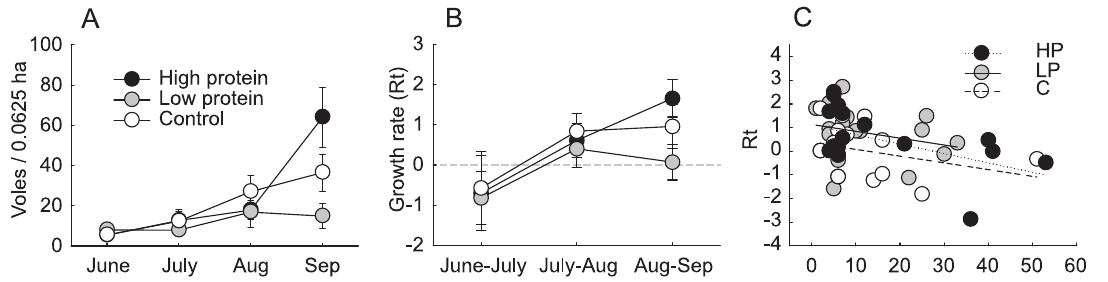
Figure 1. Size and growth of experimental field vole populations. (A) density (mean 6 se), (B) growth rate (Rt) (least squared mean 6 se), (C) population growth rate by density.